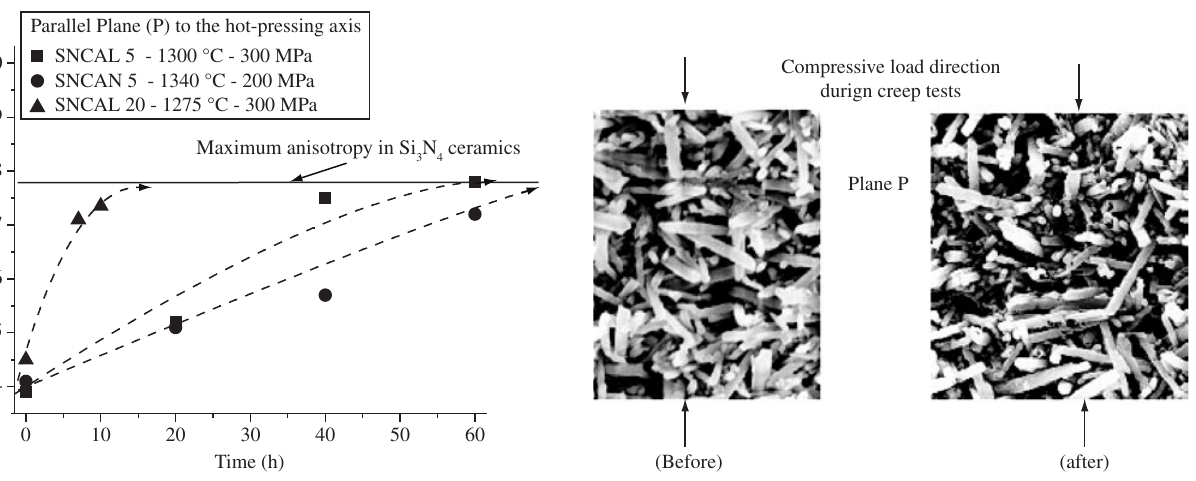
Figure 6. SEM micrographs of the sample SNCAL 20 in the P and N planes, before and after the creep